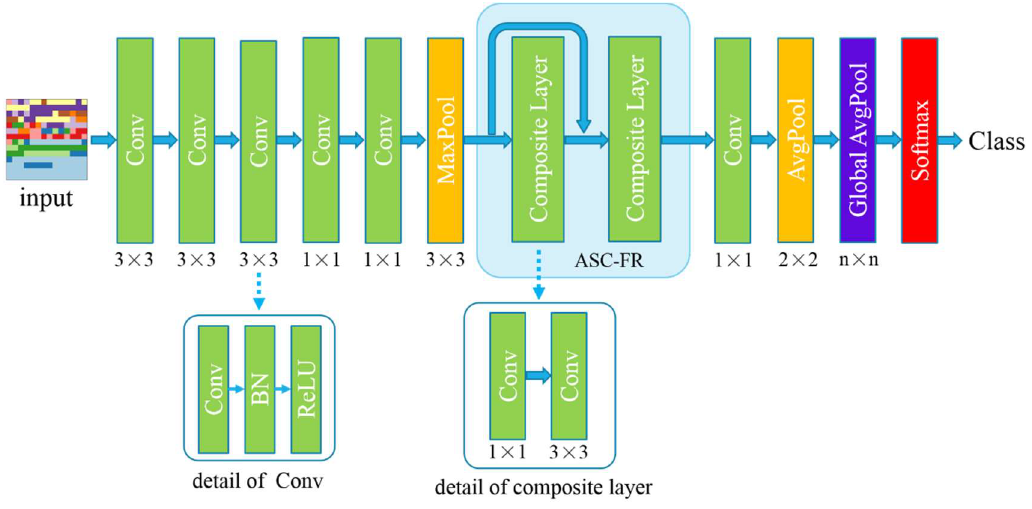
Figure 2. Proposed convolutional neural network (CNN) architecture.